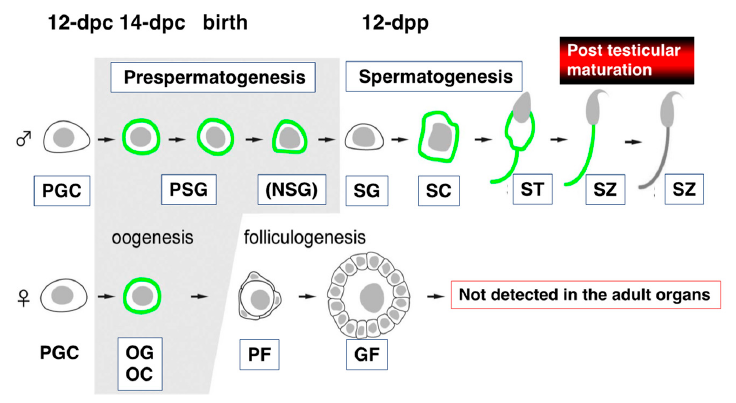
Figure 2. Molecular expression of TEX101 during gametogenesis. Germ cells that express TEX101 are indicated with bold lines . PGC, primordial germ cell; PSG, prospermatogonium or gonocyte; NSG, neonatal-type undifferentiated spermatogonium; SG, spermatogonium; SC, spermatocyte; ST, spermatid; SZ, spermatozoon, OG, oogonium; OC, oocyte; PF, primordial follicle; GF, glowing follicle (modified from [13]).